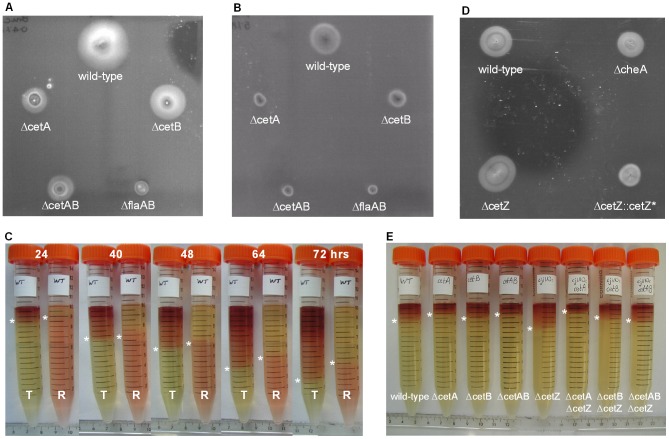
Representative swarming and taxis assays.Representative swarming plates showing wild-type, ΔcetA, ΔcetB, ΔcetAB and ΔflaAB strains after 24 hours incubation at 37°C in microaerobic conditions in: A) Brucella (0.4% agar, 0.01% TTC) and B) DMEM supplemented with 5% MEMα (0.4% agar, 0.01% TTC). C) Representative composite image of parallel TTC- and resazurin-based tube assays. Brucella soft agar was supplemented with either 0.01% TTC (T) or 0.0001% resazurin (R) and were incubated after inoculation at the top at 37°C in air and photographs taken at the times indicated. Asterisks are used to show the edge of the dye front. D) DMEM/MEMα swarming assay showing halo formation of the wild-type, ΔcheA, ΔcetZ, and ΔcetZ::cetZ* strains. E) Representative tube assay after 40 hrs incubation in air (37°C) showing migration of wild-type, ΔcetA, ΔcetB, ΔcetAB, ΔcetZ (cj1110c), ΔcetA ΔcetZ, ΔcetB ΔcetZ, and ΔcetAB ΔcetZ strains. Asterisks are used to show the edge of the dye front.